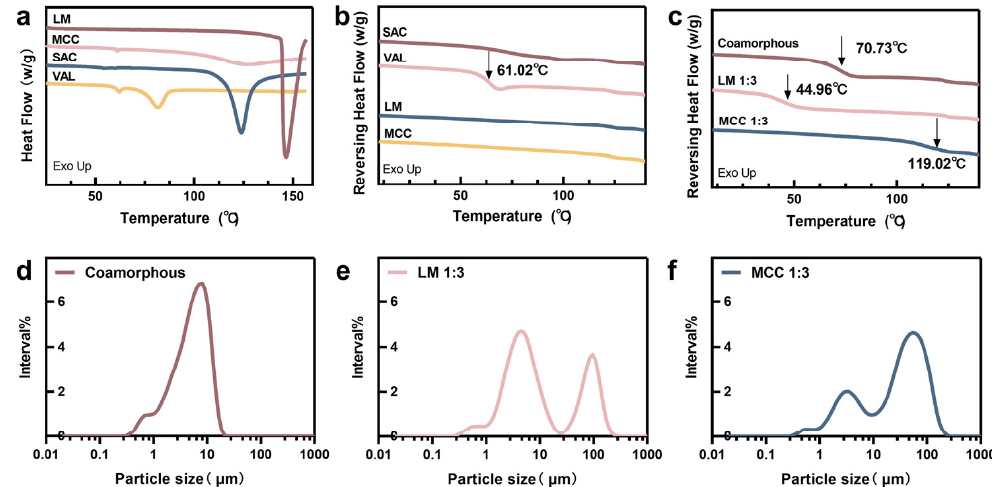
Figure 3. ( a – c ) Representative differential scanning calorimetry (DSC) thermograms of spray-dried samples, single drug, and inert carriers. The T g are indicated by black arrows. ( d – f ) Particle size distribution curves of representative preparations.